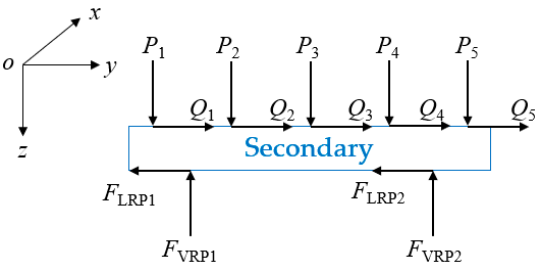
Figure 8. Force analysis of the secondary conductive plate.